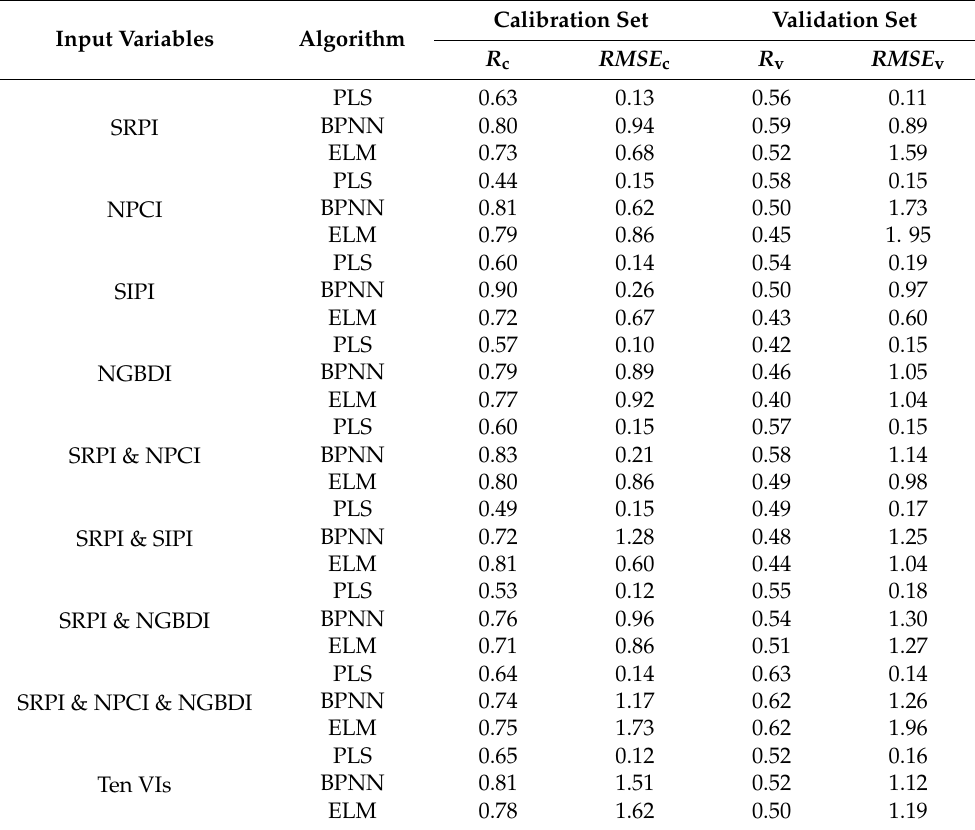
Table 7. CNC prediction results with PLS, BPNN and ELM based on VIs. Input Variables